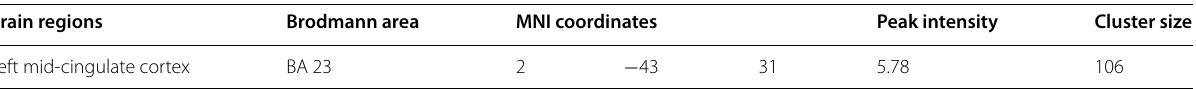
Table 3 The detailed information for ALFF differences between preoperative axial pain group and non-preoperative axial pain group Brain